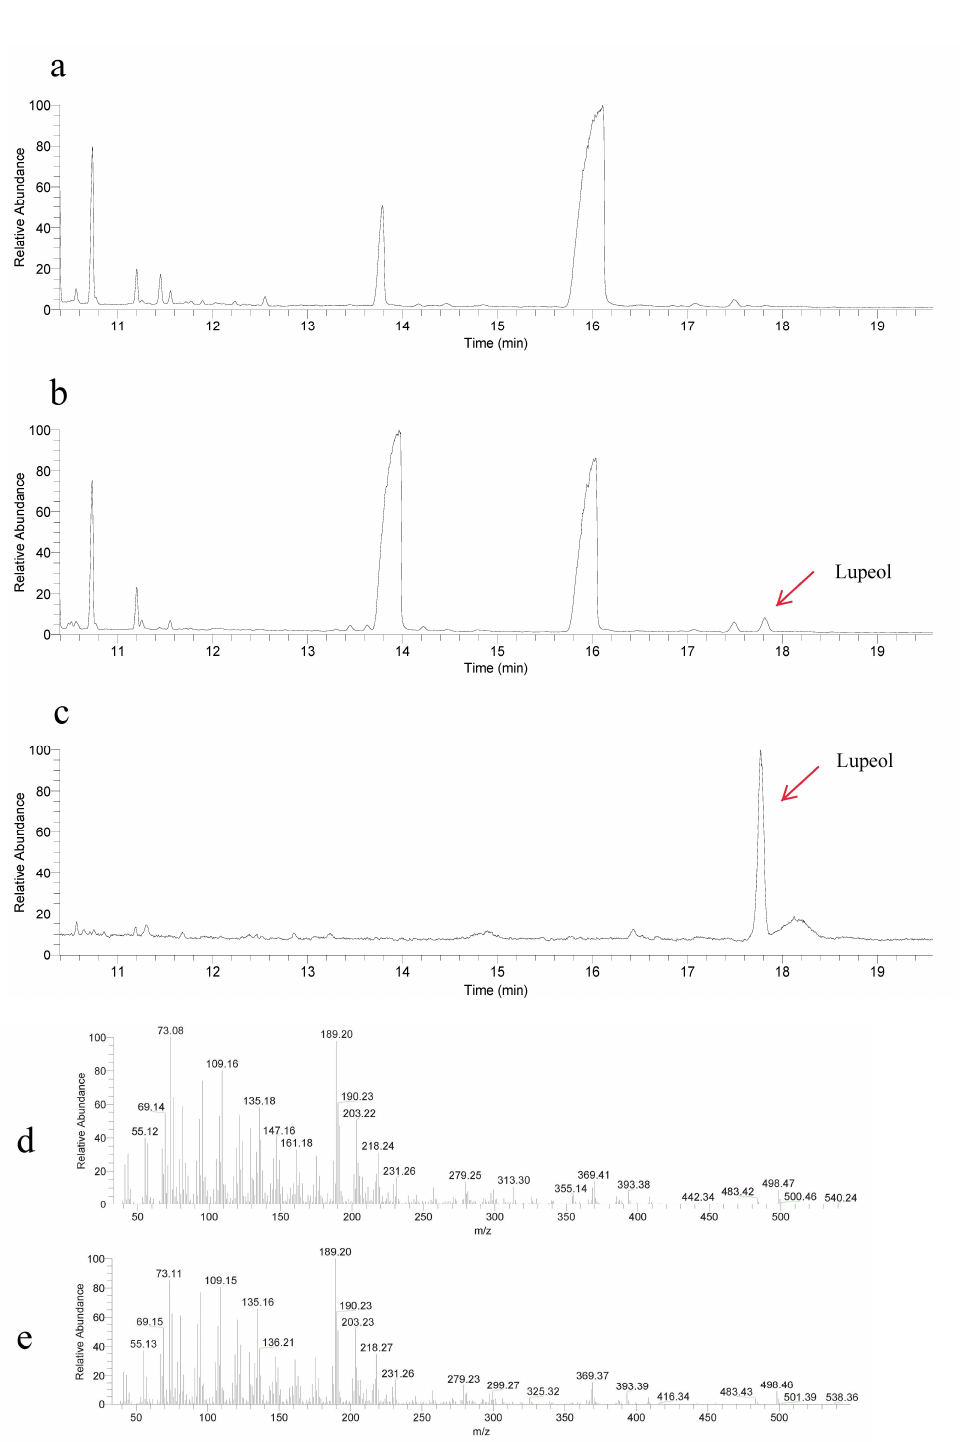
Figure 5. Gas chromatography–mass spectrometry analysis of yeast extracts overexpressing the R. rugosa lupeol synthase gene. Chromatogram for the yeast with empty vector ( a ), transformed yeast with the RrOSC12 gene ( b ), and the authentic lupeol standard ( c ). Mass spectra in a retention time of 17.8 min for lupeol in the transformed yeast ( d ) and the authentic lupeol standard ( e ).